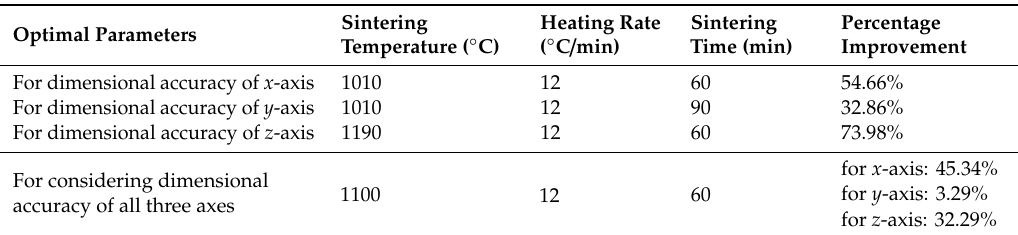
Table 9. Optimal parameters of sintering profile and percentage improvement of dimensional accuracy